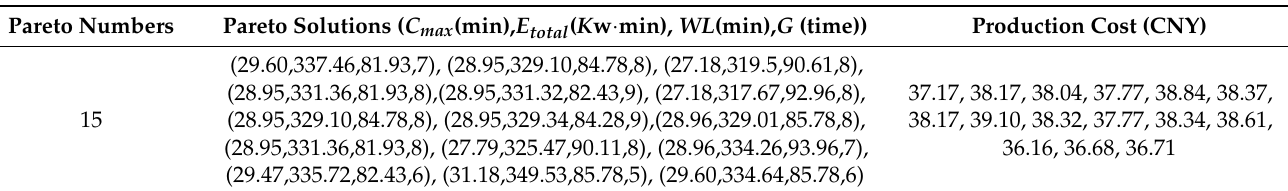
Table 8. Cutting-tool degradation model.